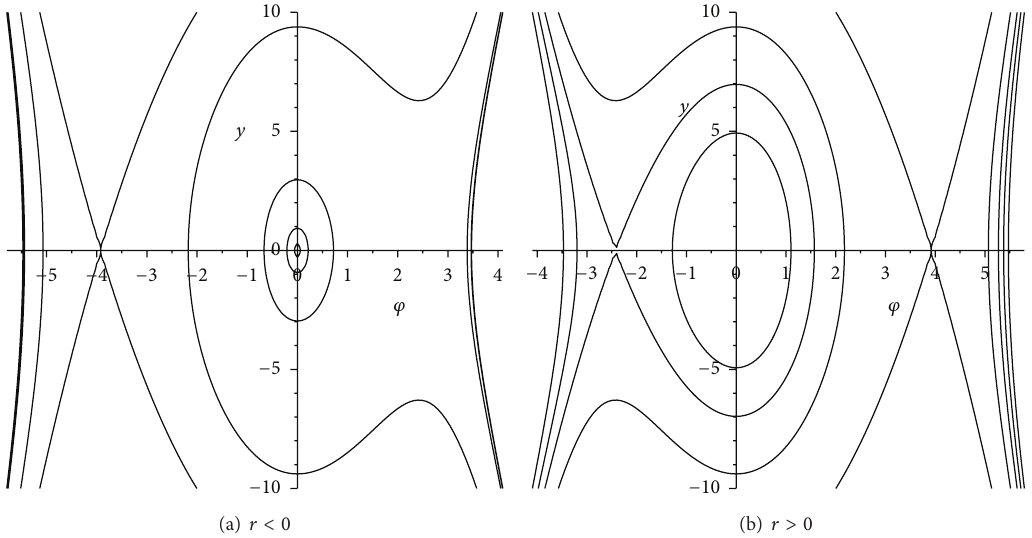
Figure 3: The bifurcation phase portraits in different regions of Figure 1(b) for the system (11).